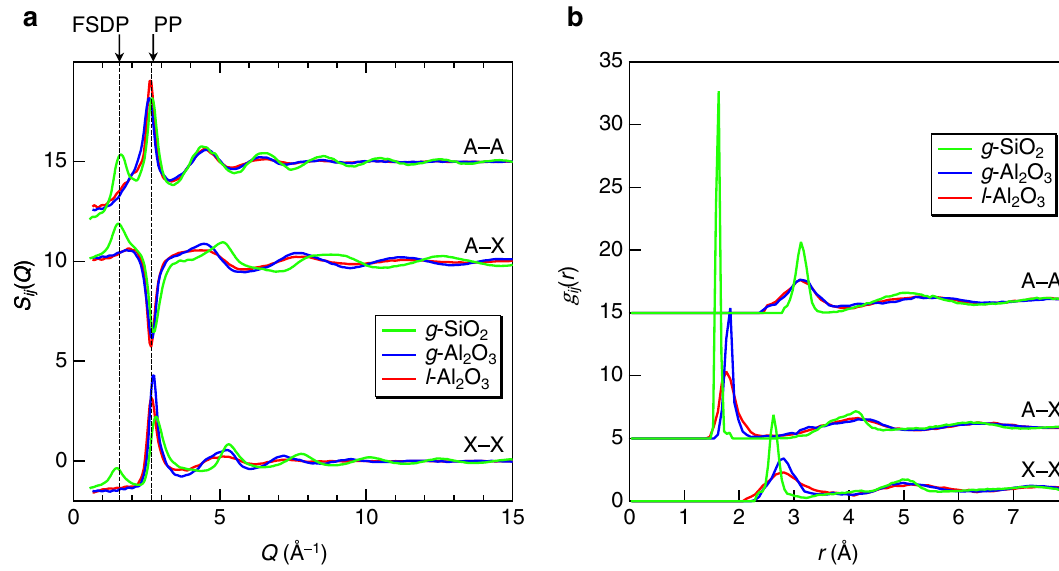
Figure 4. ( a ) Partial structure factors, S ij ( Q ), for g -Al 2 O 3 , l -Al 2 O 3 , and g -SiO 2 . ( b ) Partial pair distribution functions, g N A–X N